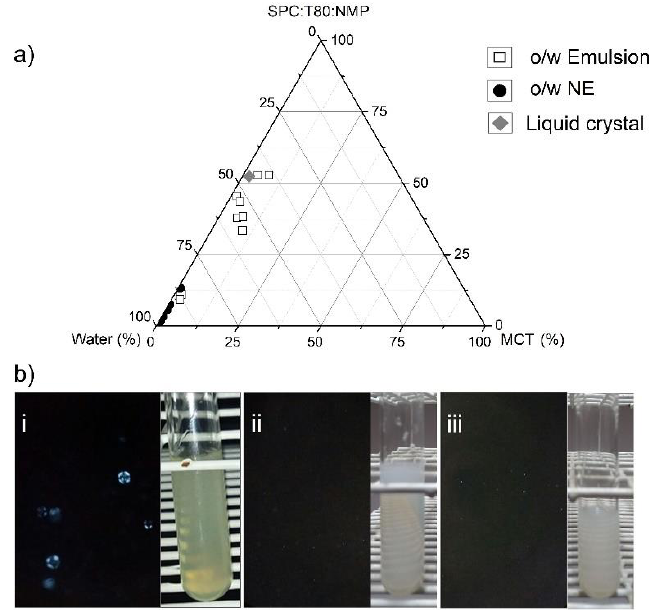
Figure 2. Phase diagram constructed at 25 °C, followed by ultra-turrax homogenization (11,000 rpm). ( a ) Pseudo-ternary phase diagrams (PTPD). ( b ) Polarized microscopy images ( left side —increased 400×) and visual aspect ( right side ) of ( i ) gel-like system, ( ii ) anionic NE and ( iii ) cationic NE-PEI.